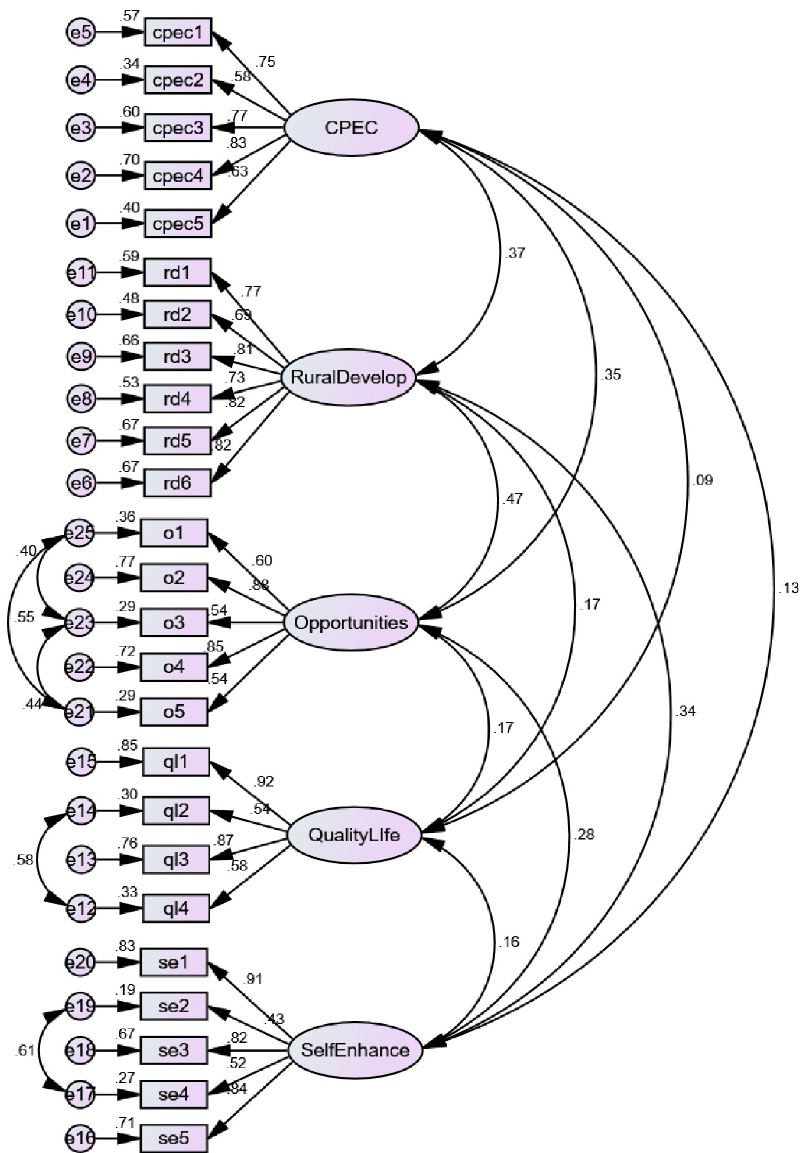
Fig 6. Measurement